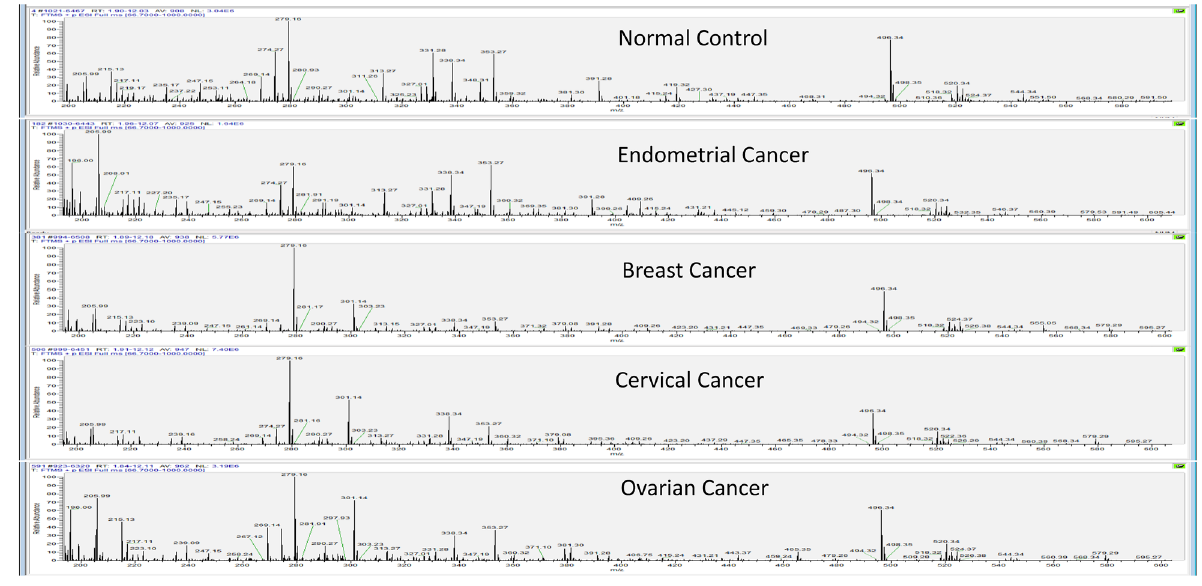
Figure 1. Ion chromatograms of representative samples from the normal control and the individual cancer groups. The total run time for the LC resolution was 14 min, with every sample run being alternated with a blank run. For the blank run involved injection of a 1:1 mixture of methanol and water. Comparatively, spectra in each case were following a trend with major changes seen from 200 to 600 m/z with the time ranging from 3 to 11 min.